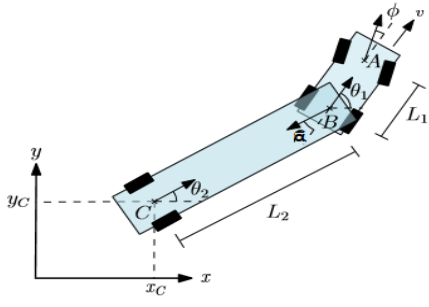
Fig. 3. The kinematic model for controller (2) Where θ1 and θ2 are the orientation angles of the truck and the trailer respectively, α=θ1–θ2, the zero value is acceptable. In Fig. 4 the fragment of the working application for con- troller (1) is presented: reaching goal B (1, –2) with the calculated angle of folding alpha0 (field with the value of 0.15 – the speci- fied accuracy of reaching the goal).